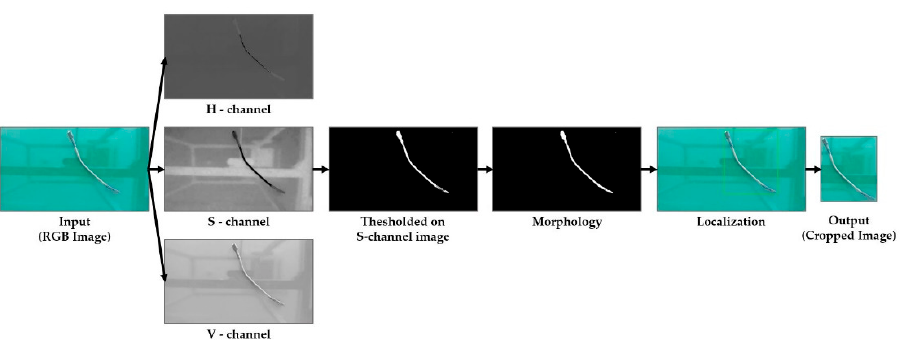
Figure 10. Representative ROI extraction result.